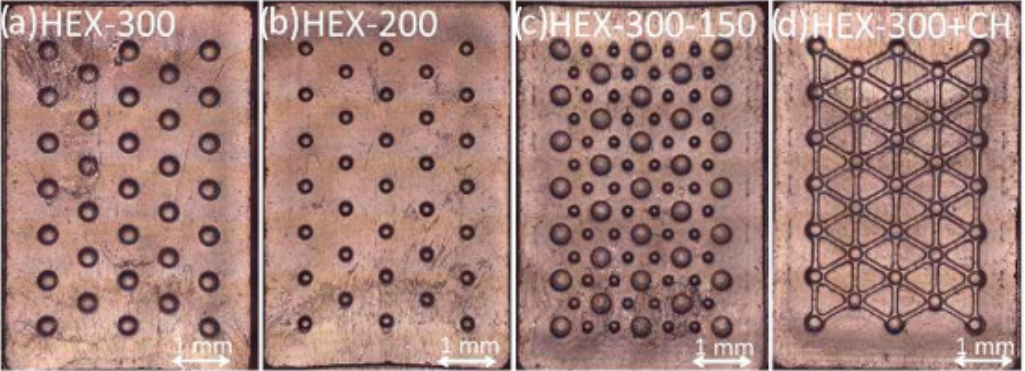
Figure 9. HDPE sample: ( a ) HEX-300; ( b ) HEX-200; ( c ) HEX-300-150; ( d ) HEX-300+CH. Table 7. HDPE sample features measurements.